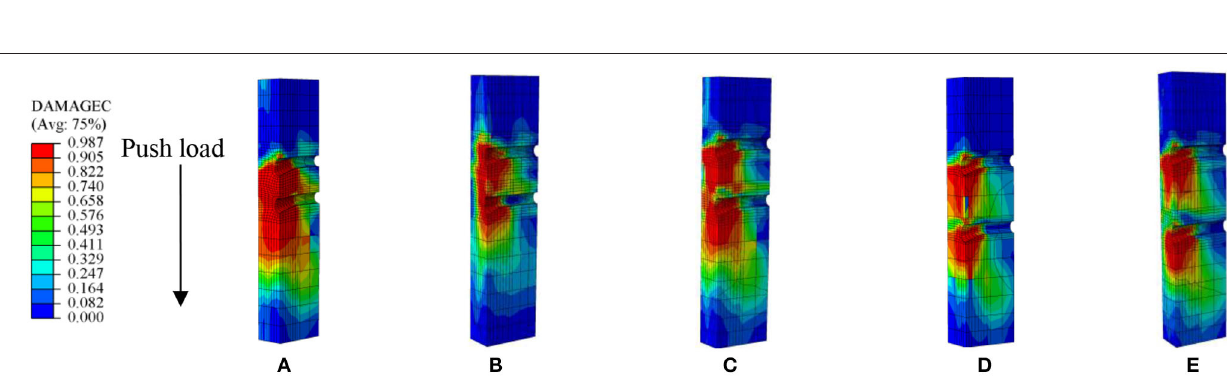
Frontiers in Materials |